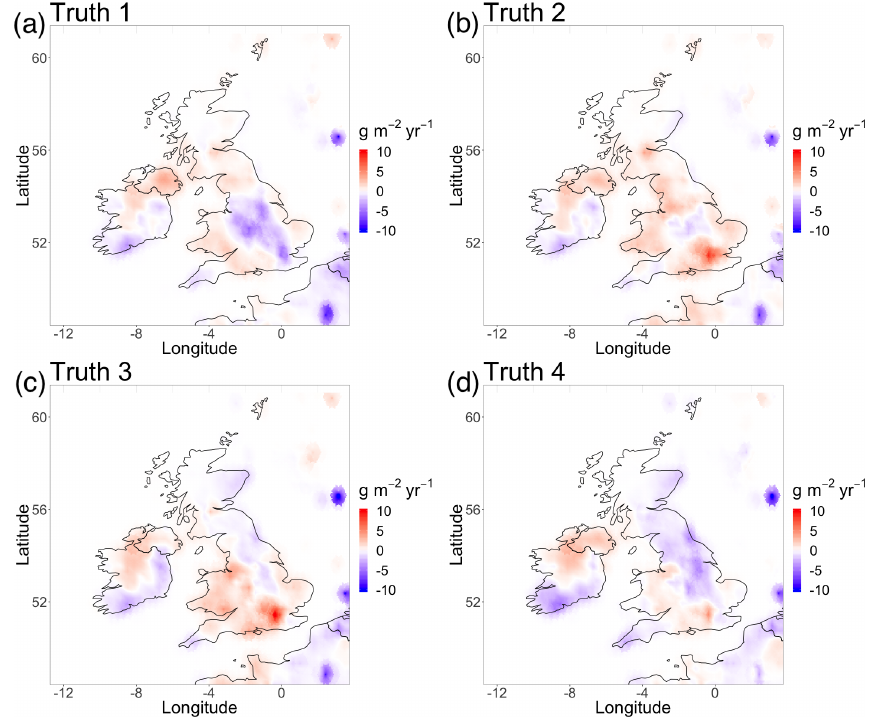
Figure 3. Time-correlated deviation of emissions from the prior mean, simulated using a Matérn field for (a) the first time period, (b) the second time period, (c) the third time period and (d) the fourth time